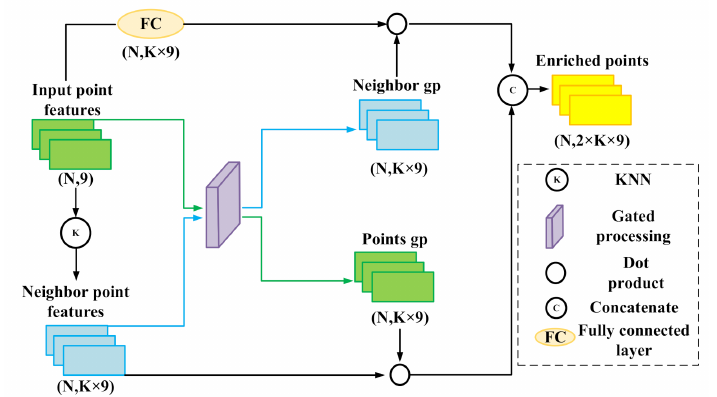
Figure 2. Point feature enrichment module (cited from [33]). The first number in the bracket is the point number, and the second is the feature